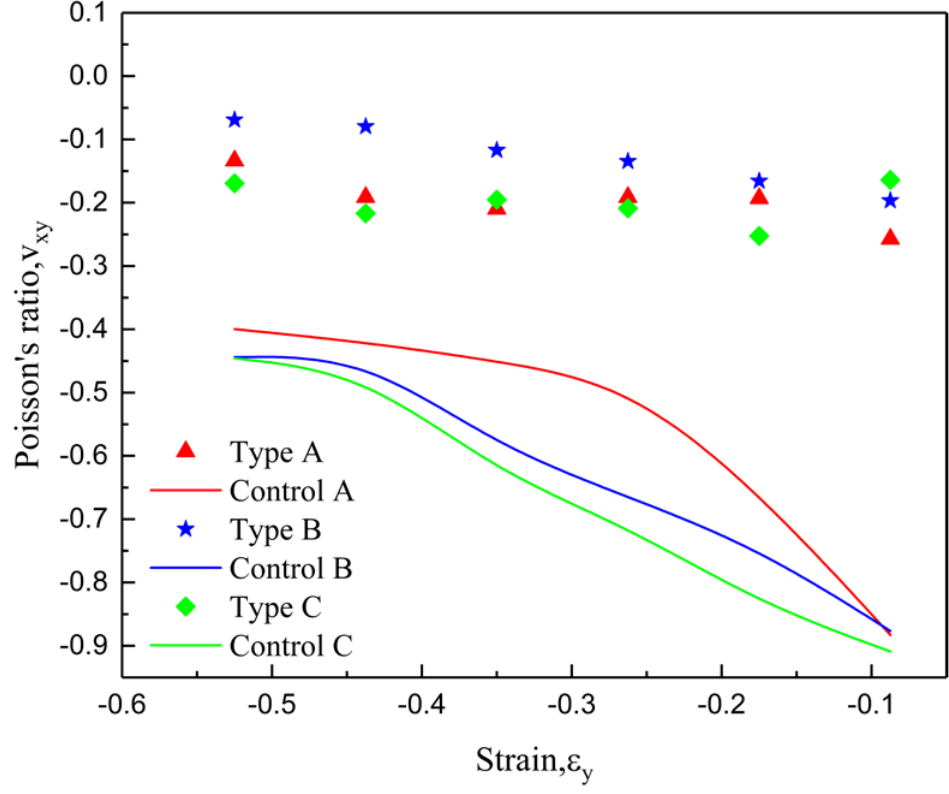
Figure 18. Simulation Poisson’s ratio comparison: Poisson’s ratio–strain curve comparison for type A, type B, and type C, as well as control A, control B, and control C.